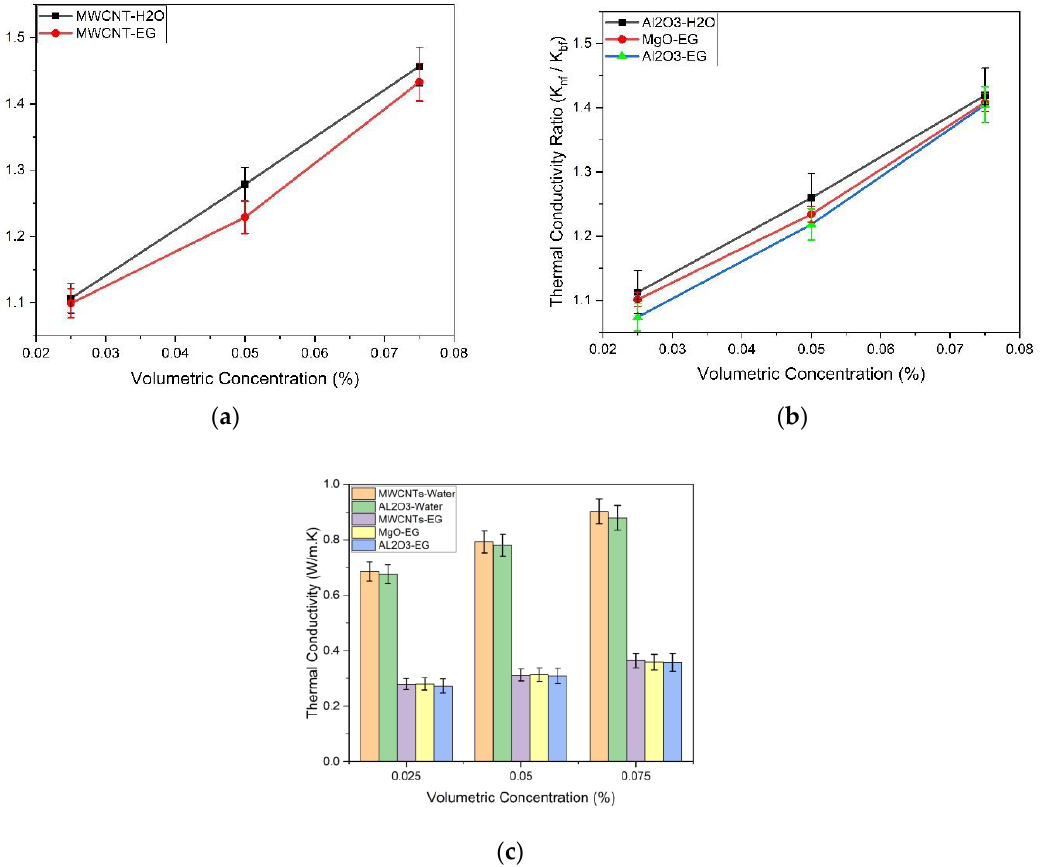
Figure 6. Variation in thermal conductivity ratio with different volumetric concentrations at 30 °C ( a ) MWCNT – H 2 O, MWCNT – EG, ( b ) Al 2 O 3 – H 2 O, Al 2 O 3 – EG, MgO – EG, ( c ) Comparison of thermal conductivity of metallic and non-metallic oxide nanofluids.